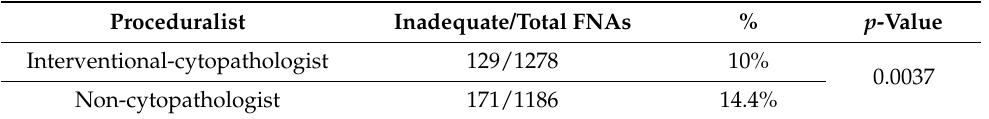
Table 1. Comparison of inadequate FNAs for molecular test between different proceduralists